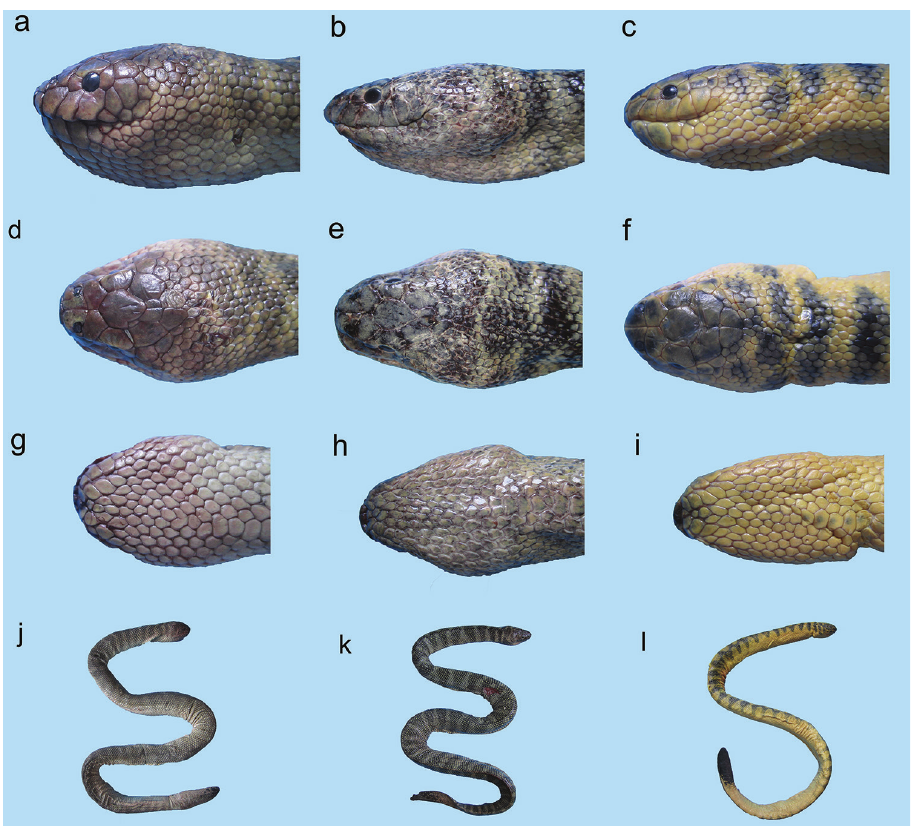
Figure 11. Hydrophis curtus : a, b, c lateral view d, e, f dorsal view g, h, i ventral view of head; and j, k, l body of a typical gray specimen, a rare black specimen and a rare yellow specimen,